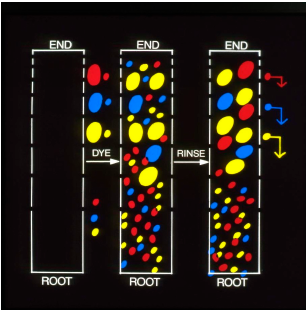
Figure 13. Visualization of interaction of semi-permanent dyes with hair.